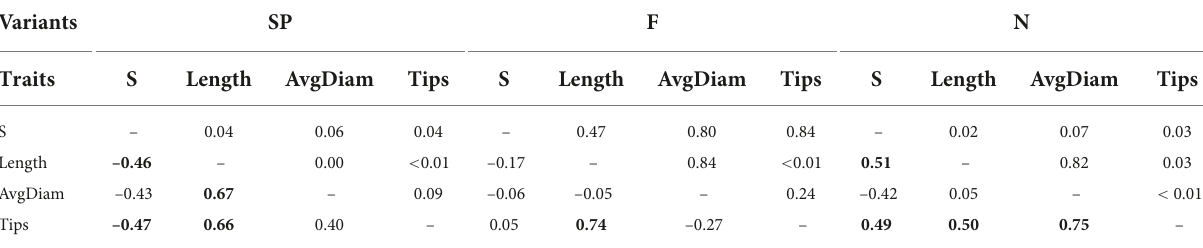
TABLE 5 Correlations between the survival rate and the significant root parameters for the experimental variants (N, F, SP): S, length (roots), average diameter (roots), and tips (roots).